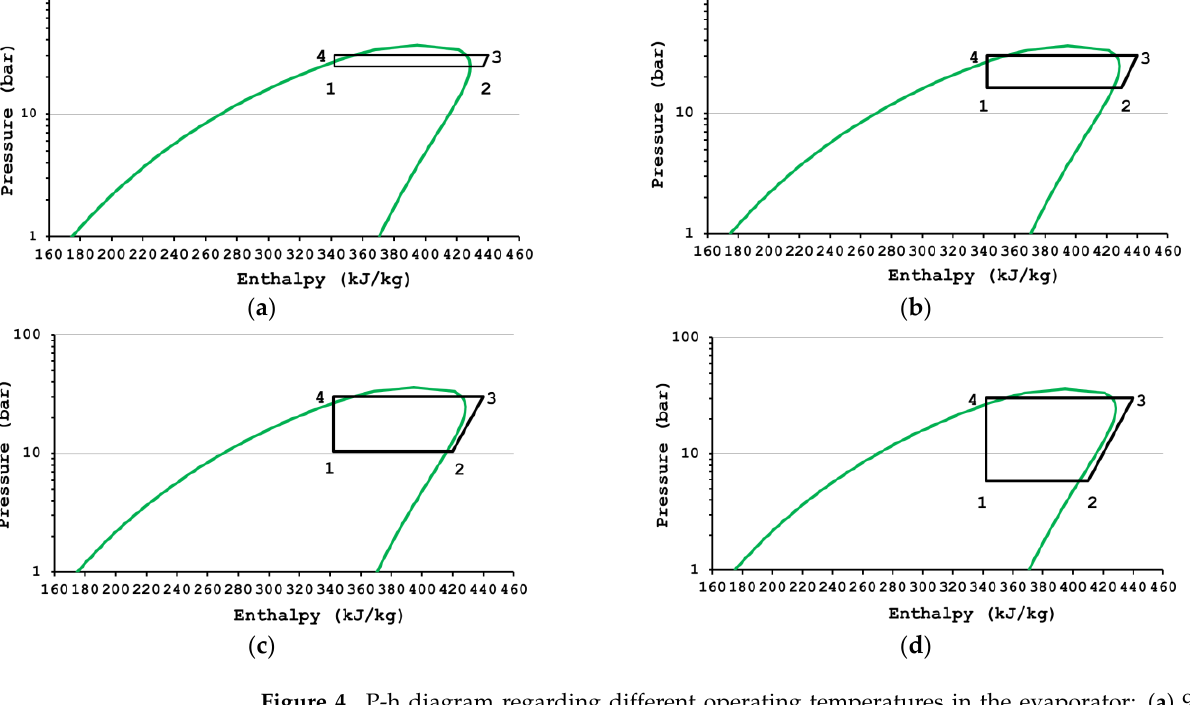
Figure 4. P-h diagram regarding different operating temperatures in the evaporator: ( a ) 90 °C, ( b ) 70 °C, ( c ) 50 °C and ( d ) 30 °C.